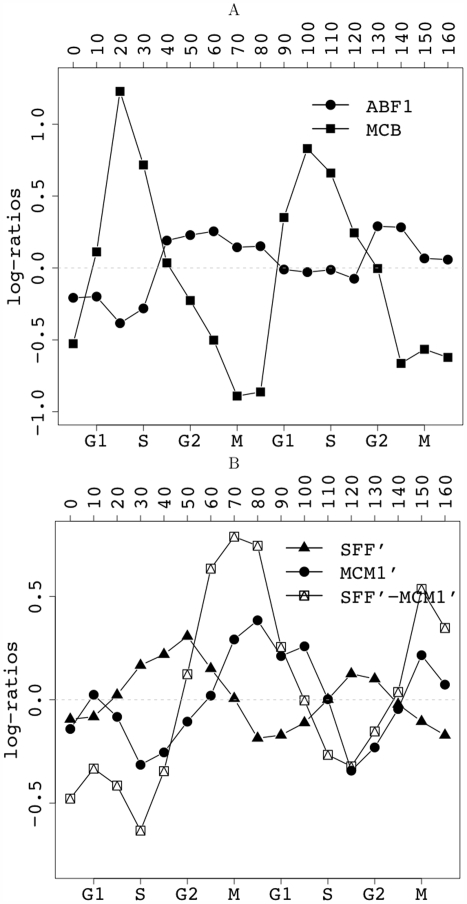
Time courses for (A) MCB and ABF1 RCs and (B) SFF' and MCM1' RCs in cell cycle.Plotted are traces of average expression profiles of the genes in the corresponding RC.